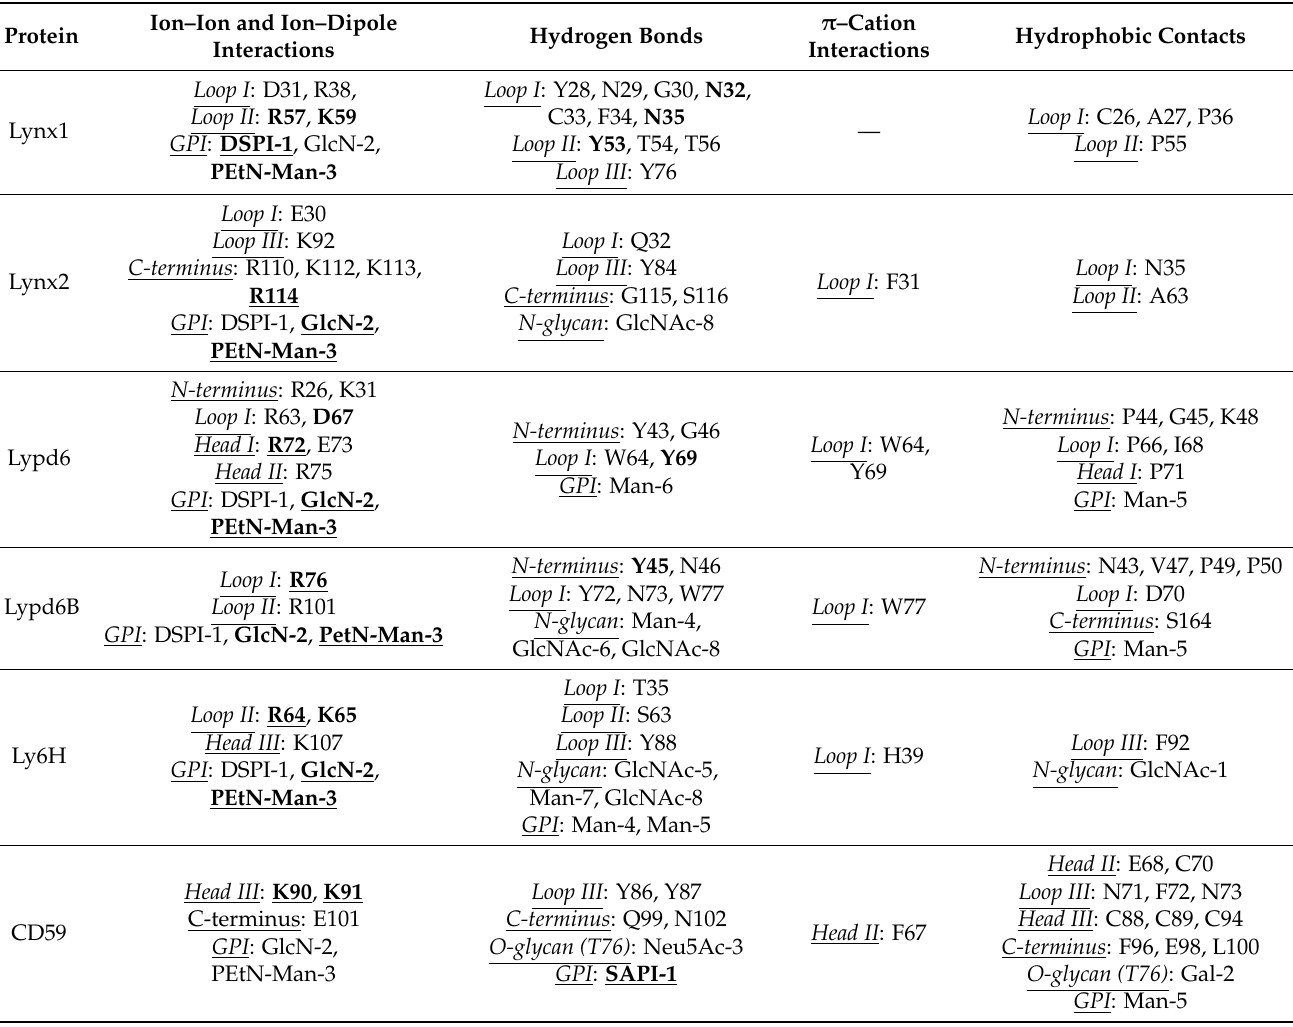
Table 2. Interactions of GPI-anchored Ly6 proteins with membrane lipids a